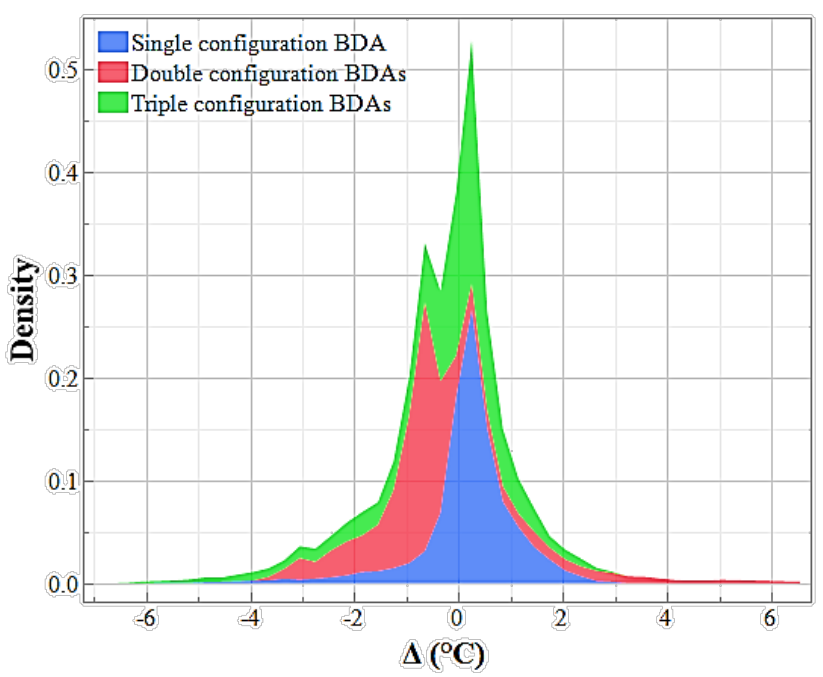
Figure 5. Differential stream temperature (downstream–upstream) densities for the BDA configurations over the post-BDA installation period (2018–2019).